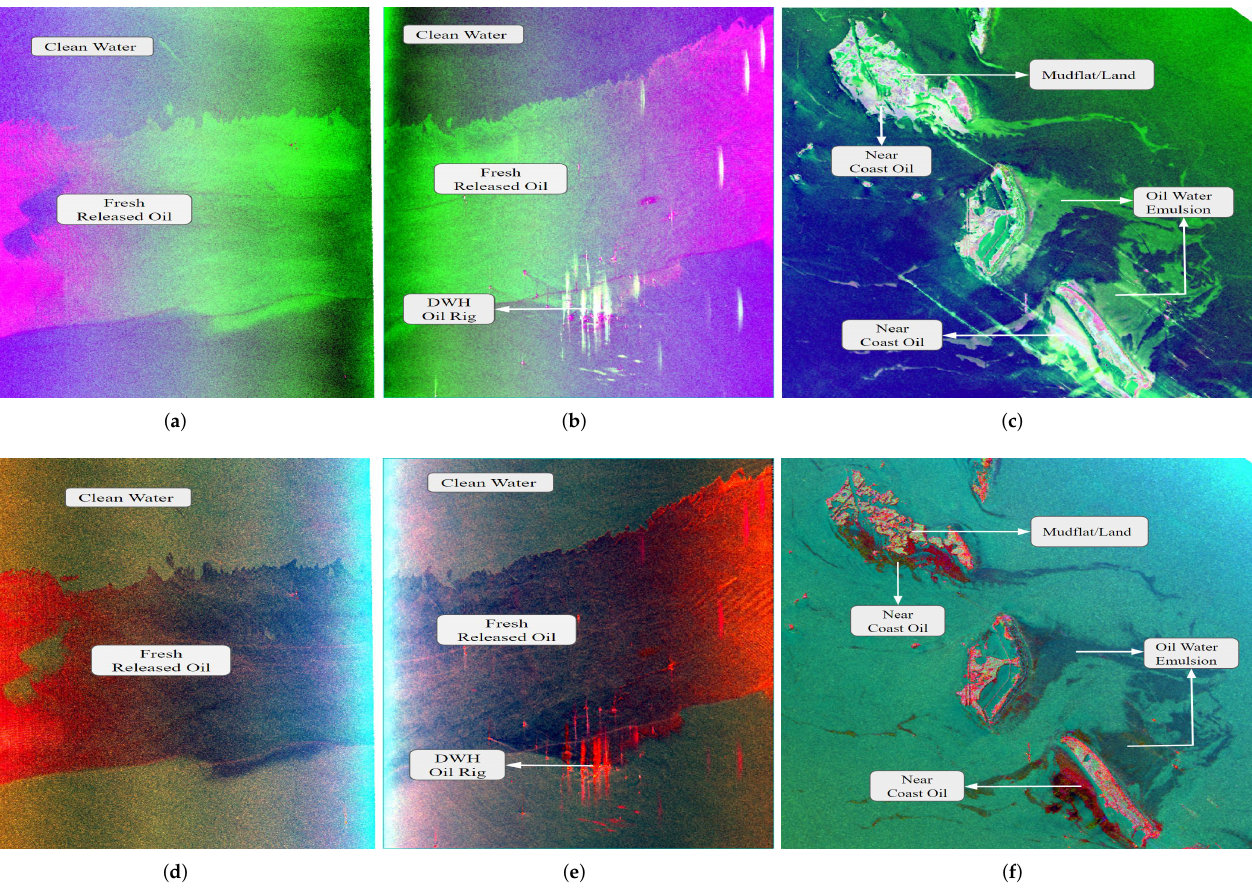
Figure 9. Comparative analysis of image generated using combination of entropy (red), anisotropy (green) and alpha (black) ( H / A / α ) using conventional T3 ( a – c ) and log transformed T3 ( d – f ) showing their capability in detecting and differentiating different emulsions of